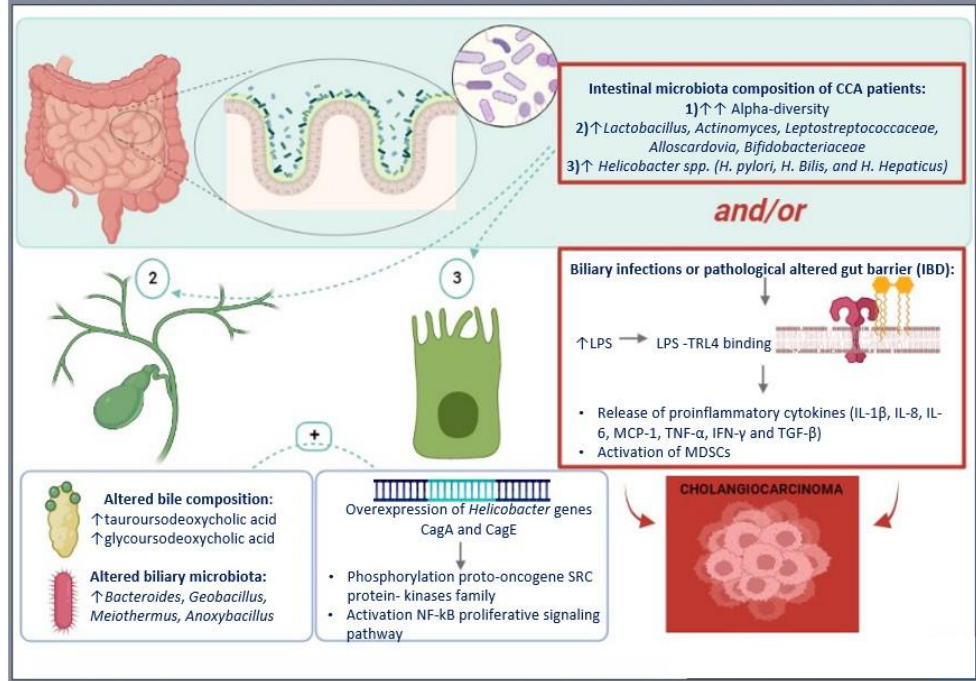
Figure 1. Microbiota alterations on CCA pathogenesis. Hypothesized role of the microbiota in chol- angiocarcinoma and mechanisms of action. cholangiocarcinoma and mechanisms of